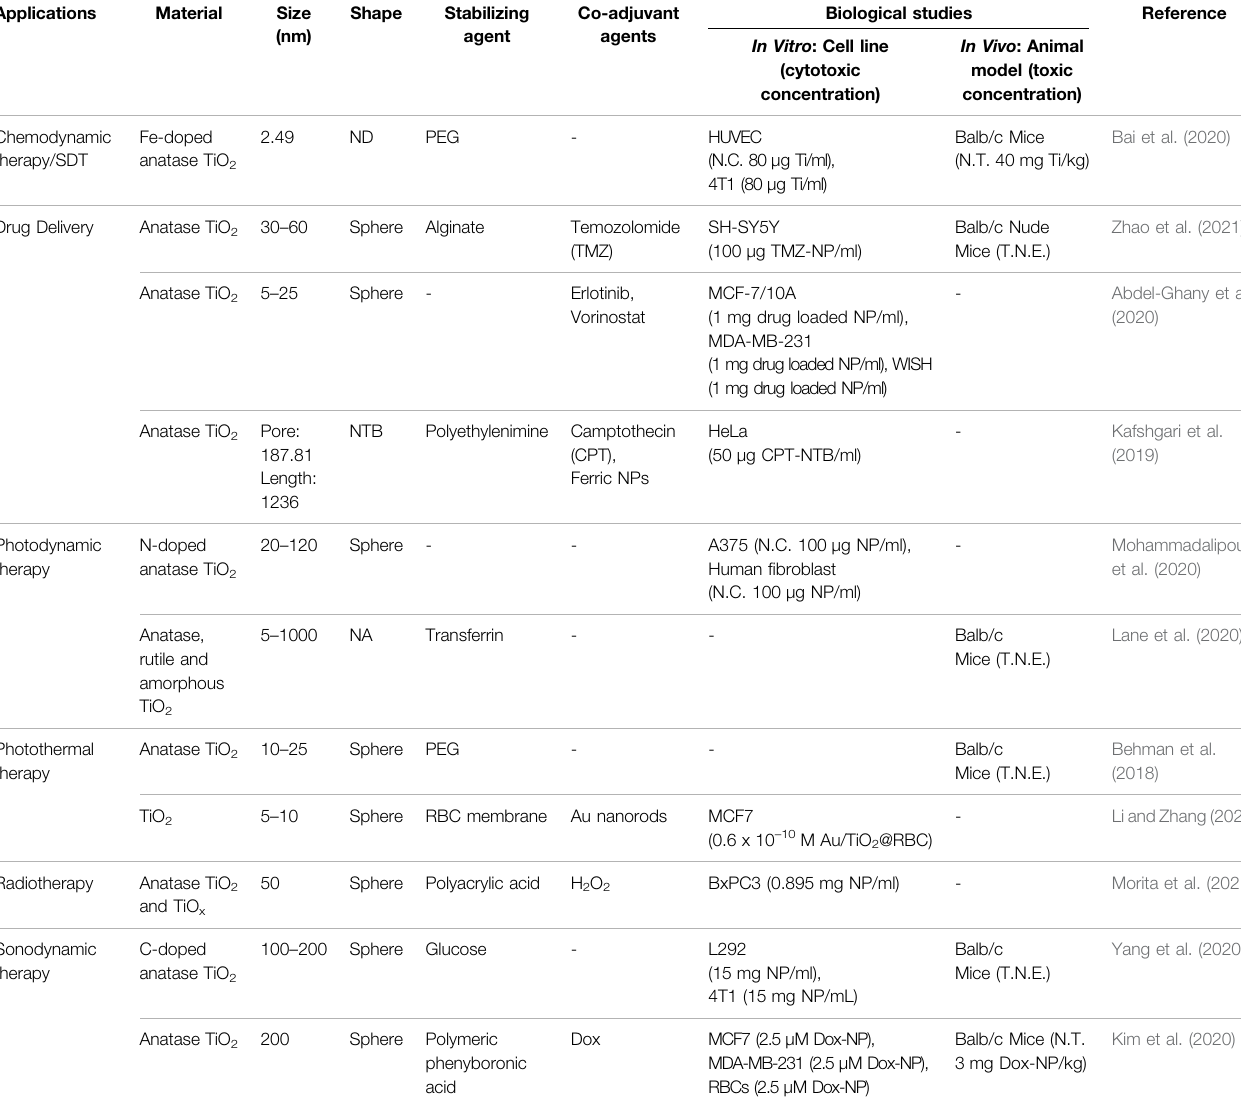
TABLE 1 | Examples of TiO 2 -based nanomaterials and its application in cancer theranostics.